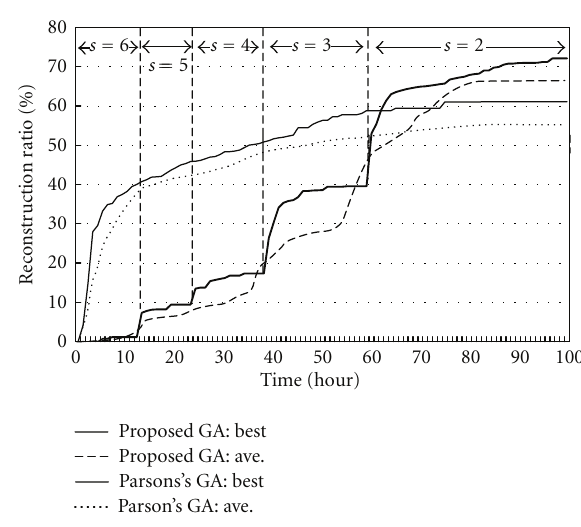
Figure 8: The improvement of the reconstruction ratio: AMCG